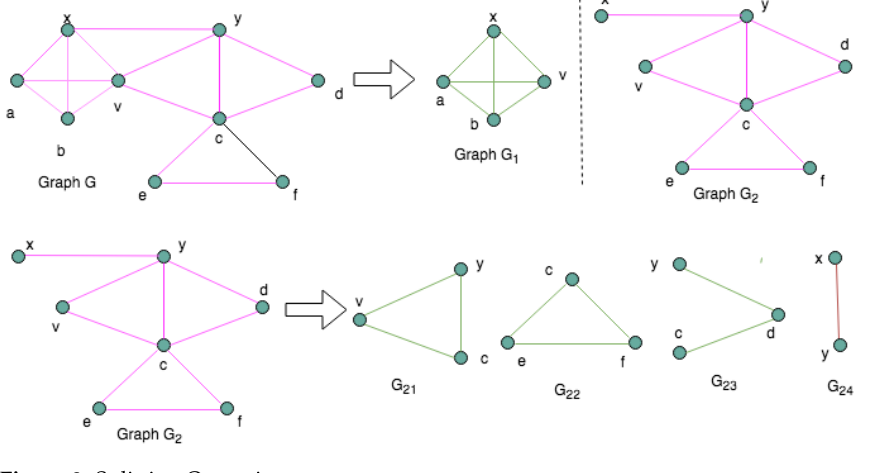
Figure 3. Splitting